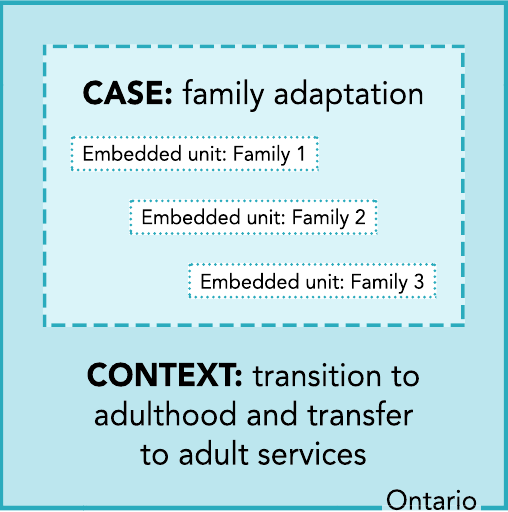
Figure 1: Single-case study binding with embedded units. The case is “ family adaptation ” in the context of the transition to adulthood and transfer to adult